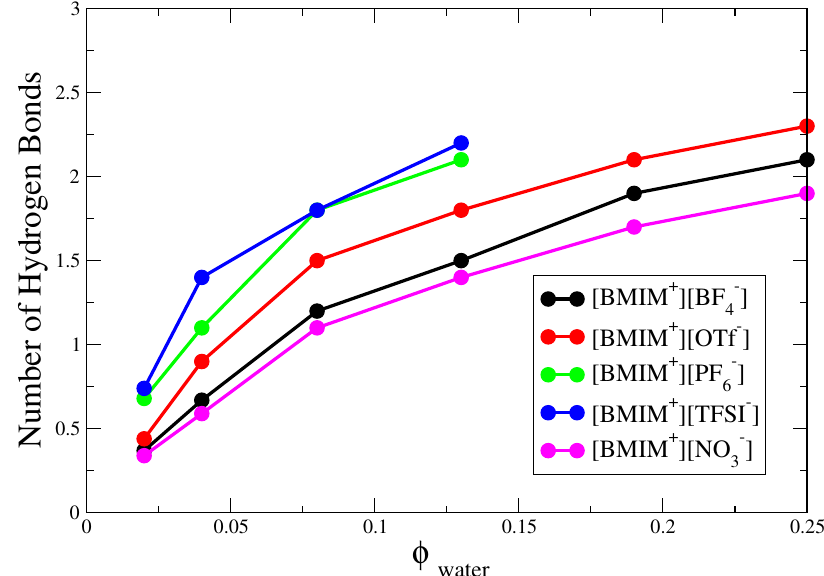
Figure 3. Average number of water-water hydrogen bonds per molecule for IL/water mixtures of 0.02 ≤ φ water ≤ 0.25 water volume